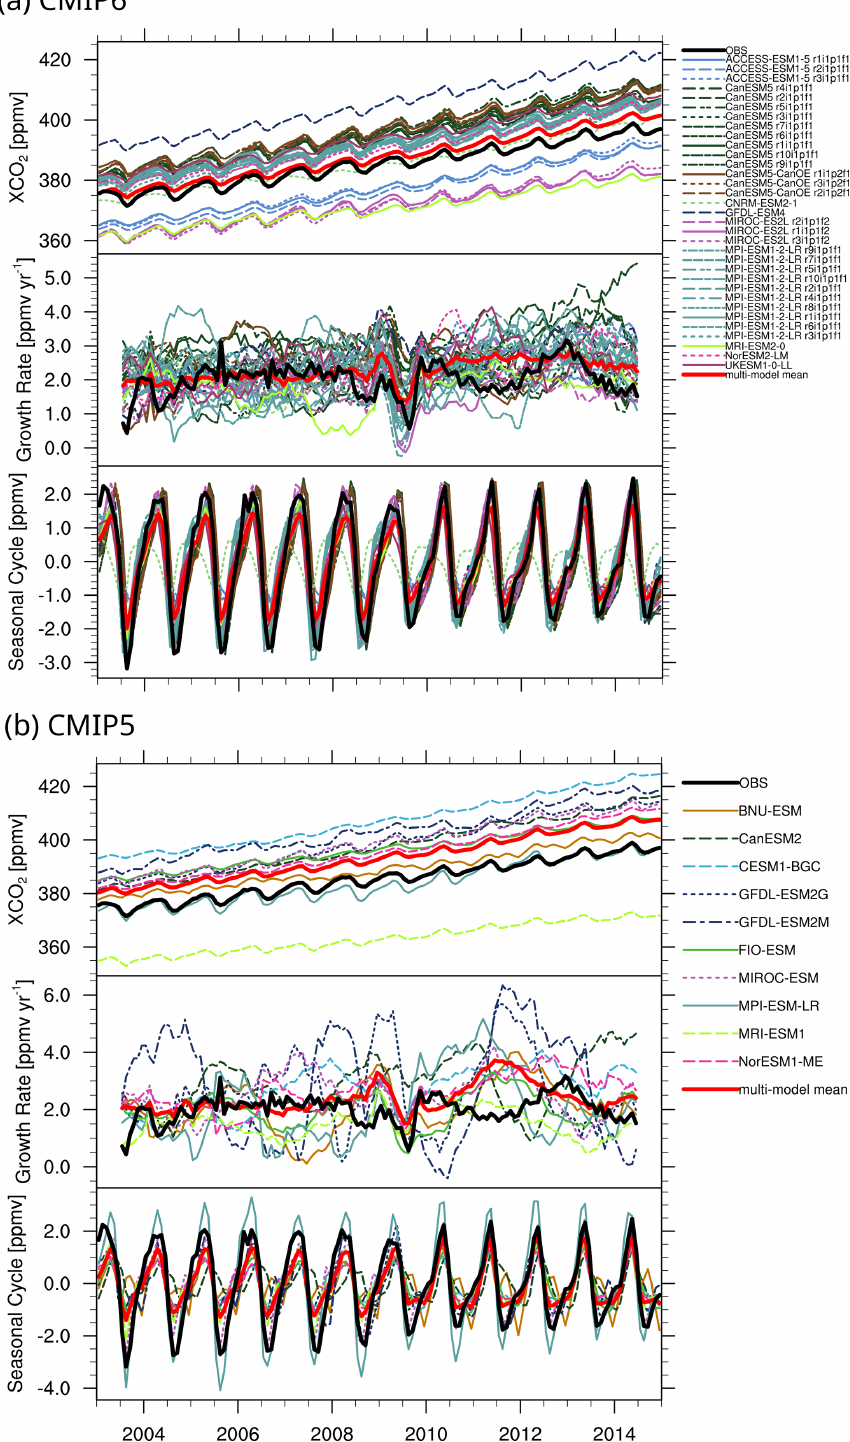
Figure 3. (a) Global time series of monthly mean column-averaged carbon dioxide (XCO 2 ) from 2003 to 2014 for the emission-driven CMIP6 model simulations in comparison to satellite XCO 2 data (bold black line). The model output is sampled as the satellite data. The top panels show the time series, while the middle panels show the computed monthly growth rate, which has been used to detrend the data to obtain the seasonal cycle shown in the bottom panel. All available ensemble members for each model are shown to demonstrate the intrinsic variability of the models. (b) Same as Fig. 3a but for CMIP5. Only one ensemble member is